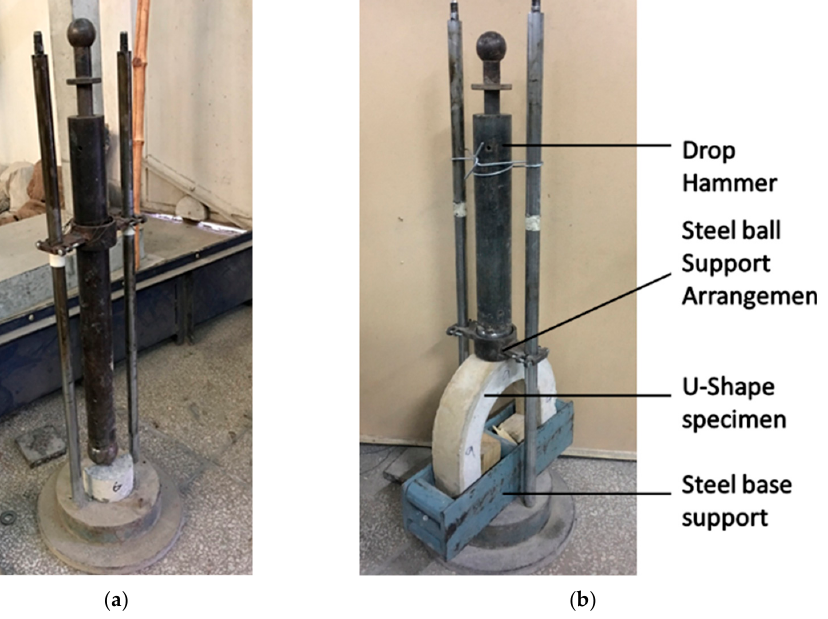
Figure 6. Arrangement for drop weight ( a ) drop weight test, ( b ) U-shaped